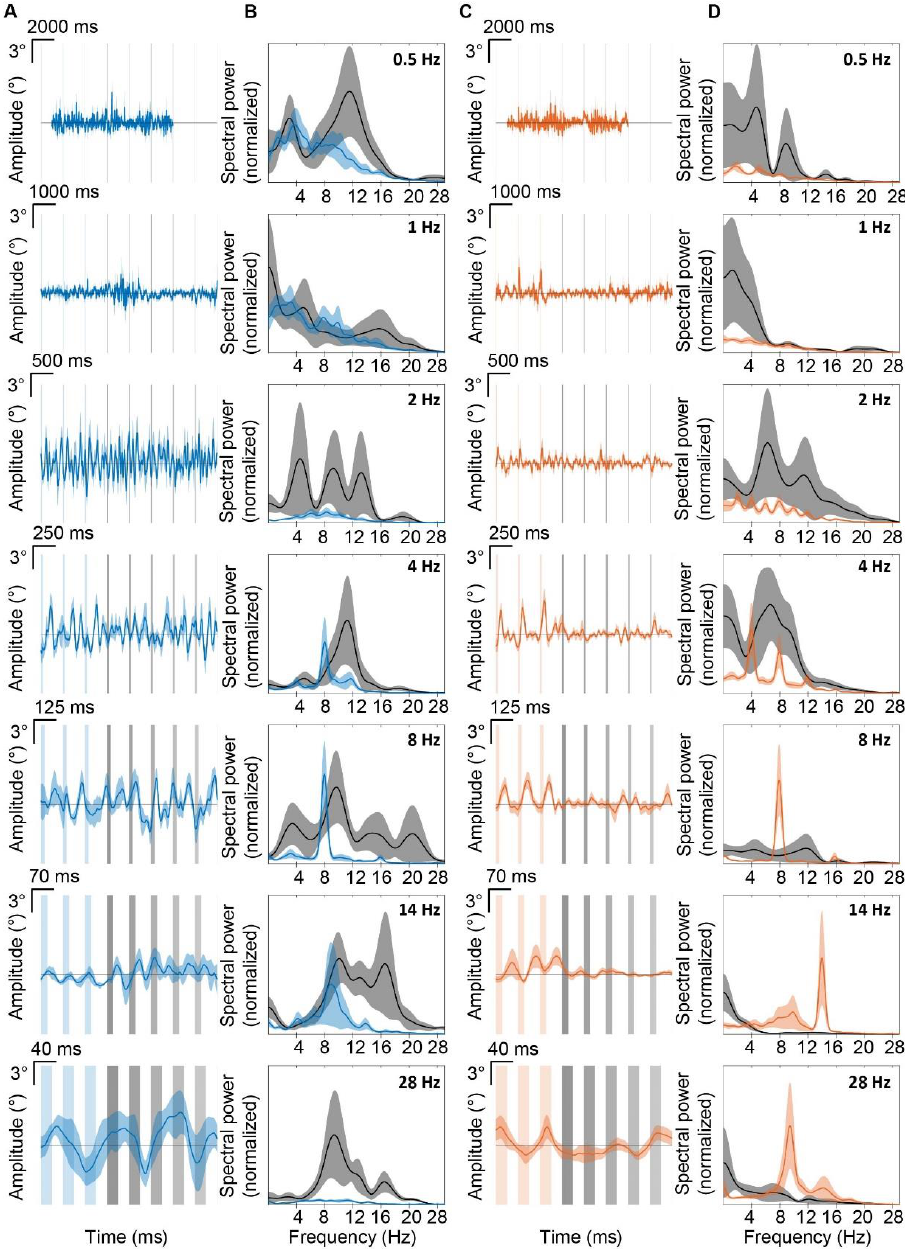
Figure 5. Entrainment of whisker movement is sustained by Purkinje cell activity. ( A ) shows mean whisker traces before and after the end of a train of stimuli of PC stimulation (left). Stimuli are indicated by blue bars. Grey bars indicate the timing at which subsequent movement could be expected if the whisker would be keeping oscillating at the frequency of stimulation (left). ( B ) shows power spectra during the period of SS stimulation (blue lines) and the power spectra during 1000 ms after the last stimulus (grey lines). Shaded areas indicate mean ± SEM. ( C , D ) are the same as ( A , B ), but for climbing fiber stimulation (orange lines). Note that the power spectra are different for the period before and after the end of the stimulation.